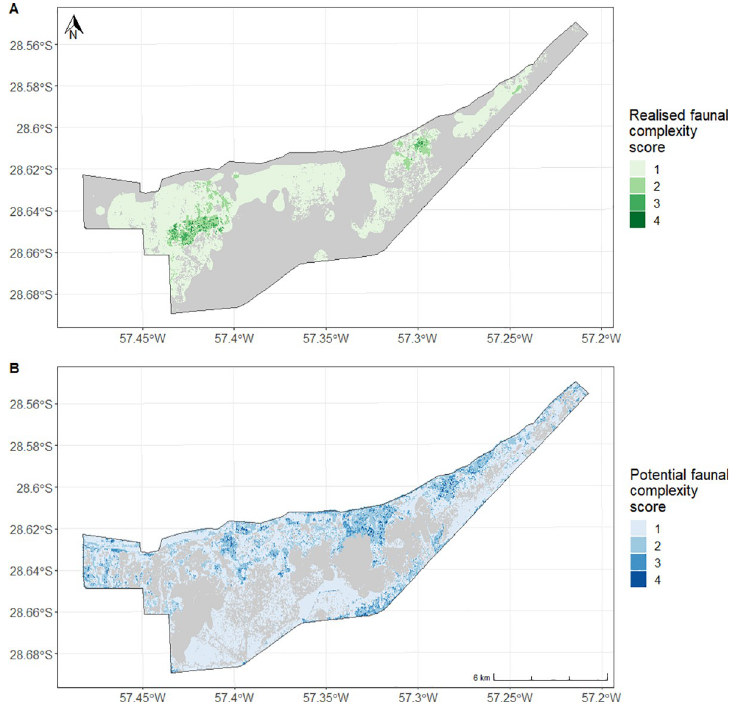
Fig 5. Faunal complexity score. (A) Realized faunal complexity score. Map of the number of species with realized faunal complexity (predicted probability of presence of more than 0.5, inside the species range) in our site. (B) Potential faunal complexity score. Map of the number of species with potential faunal complexity (predicted probability of presence of more than 0.5, beyond the species range) in our site.